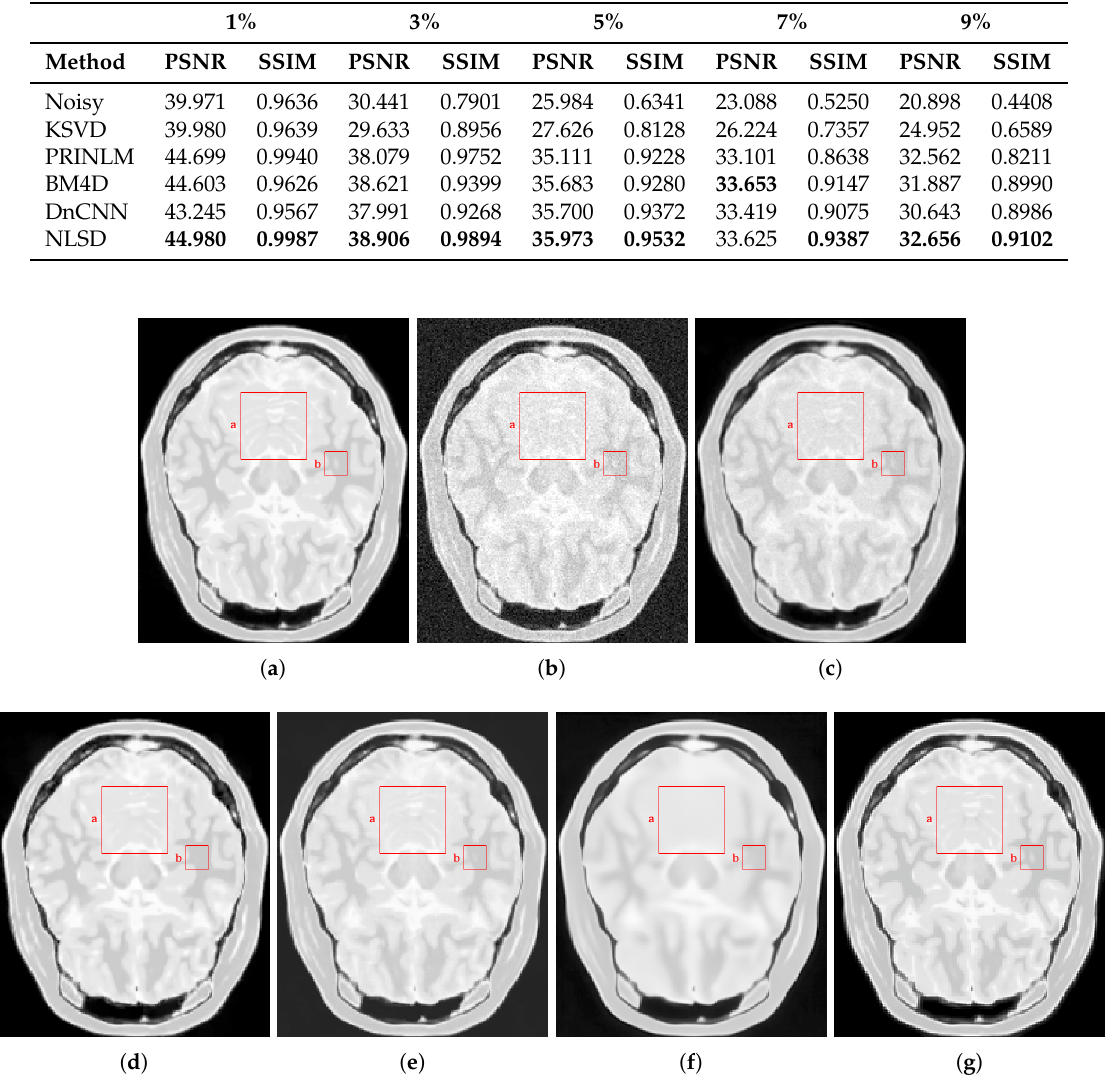
Table 3. Comparison of the different methods evaluated on the PDw synthetic noise-free MR image corrupted with different levels of Rician noise. Bold highlights indicate the best results.